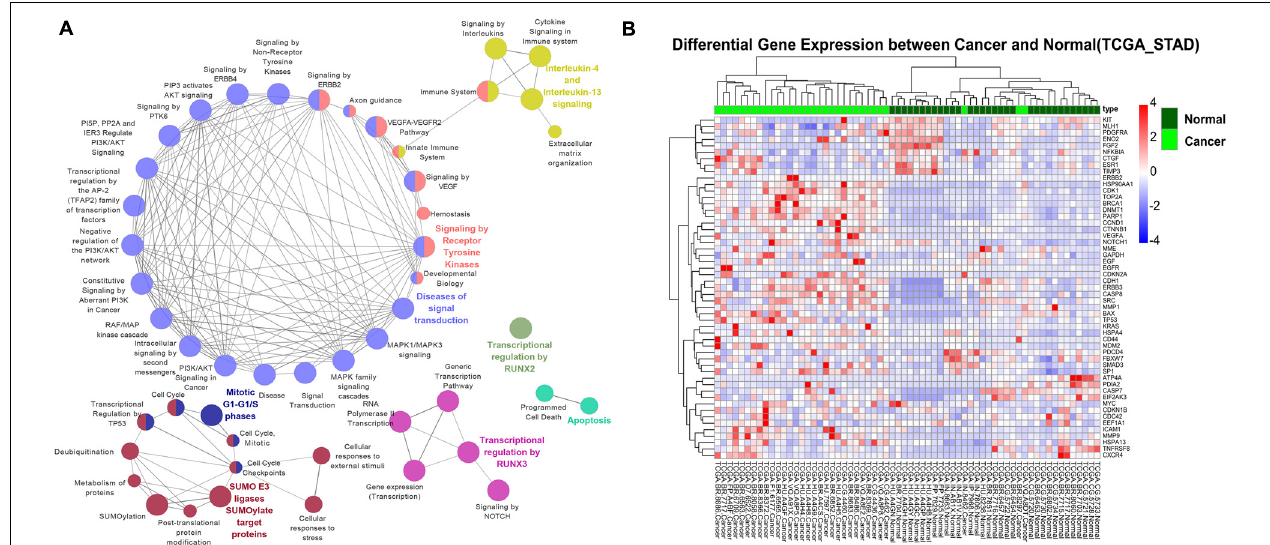
FIGURE 4 | The association between oncogenic pathways and epigenetic modifications. (A) The Reactome pathway enrichment analysis for 53 essential hub genes. (B) Hierarchical clustering of 64 gastric cancer samples (32 tumor samples and 32 corresponding non-tumor adjacent samples) from TCGA using expression profiles of epigenetically regulated genes in key signaling